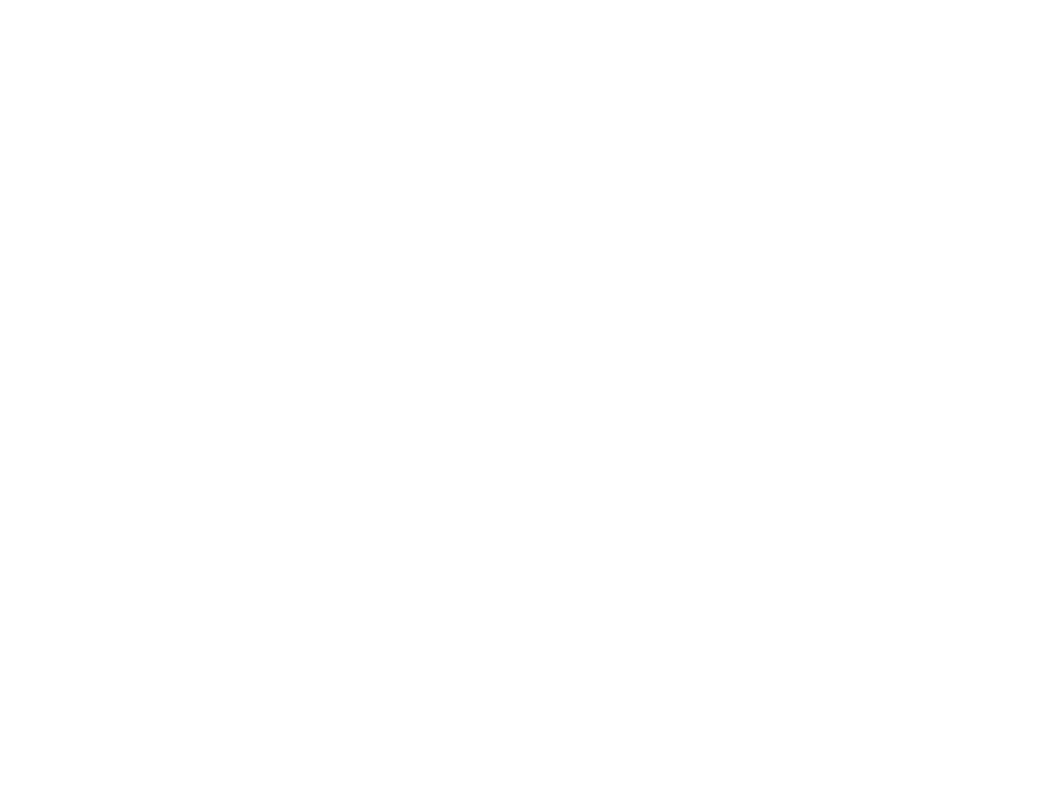
Table 9. Evaluation by entity-linking (ten-fold cross